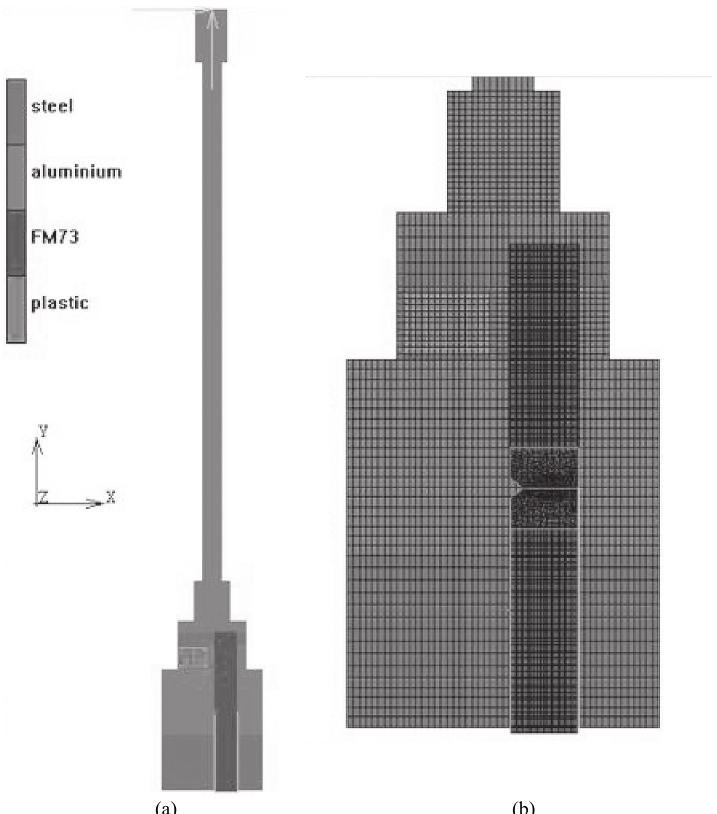
Fig. 8. Finite element modelling. (a) whole model. (b) Magnification of sample and striking area of